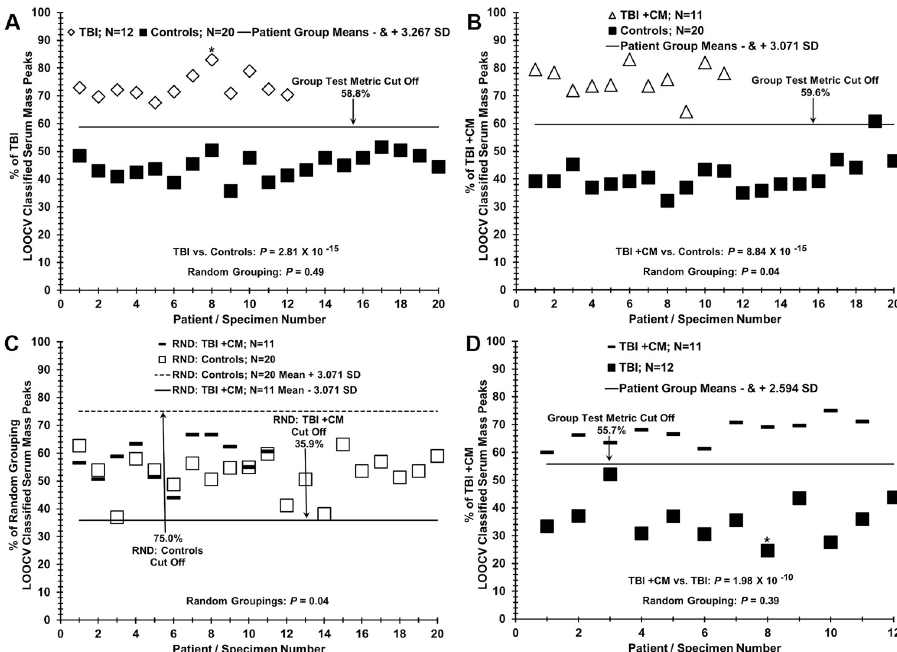
Fig 5. Distinguishing sera of TBI patients with and without chronic migraine (CM). (A) Sera discrimination of patients with TBI alone (diamonds) versus sera from control individuals (dark squares) by % of LOOCV classified mass peak analysis. (B) Sera discrimination of patients with TBI plus CM (triangles) versus sera from control individuals (dark squares). (C) Non-serum sample discrimination observed when the two different sample groups in B are mixed together randomly followed by the same LOOCV mass peak analysis. (D) Sera discrimination of patients with TBI plus CM (dashes) versus TBI alone (dark squares) by % of LOOCV classified mass peak analysis. An � indicates a female volunteer and no experimental segregation is observed from the male volunteers in this